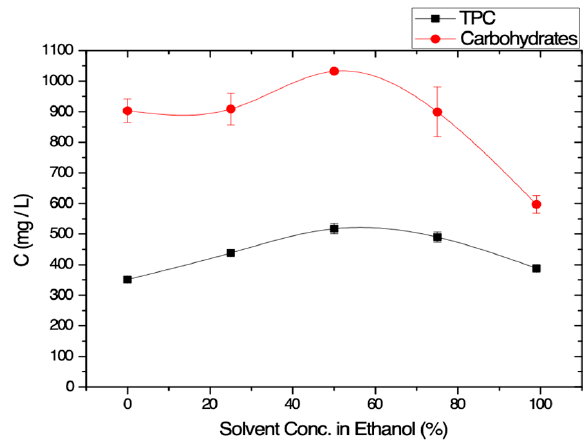
Figure 2. Total phenolic content (TPC) and carbohydrates concentrations obtained after the extraction experiments using solvent of varying concentration in ethanol (95% purity).